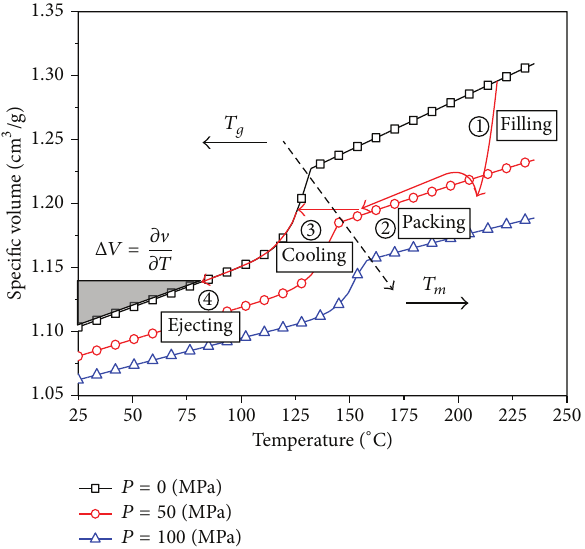
Figure 1: Trace of an injection molding cycle in a PvT diagram.